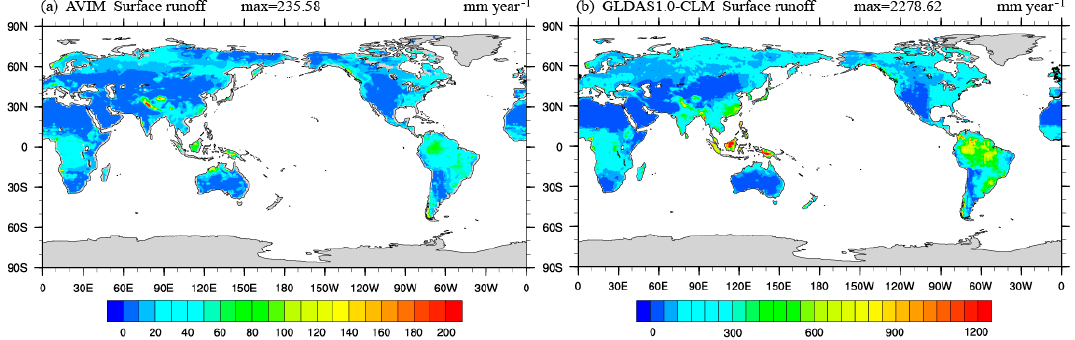
Figure 2. Spatial distribution of the annual mean surface runoff in the AVIM and GLDAS1.0 CLM datasets.